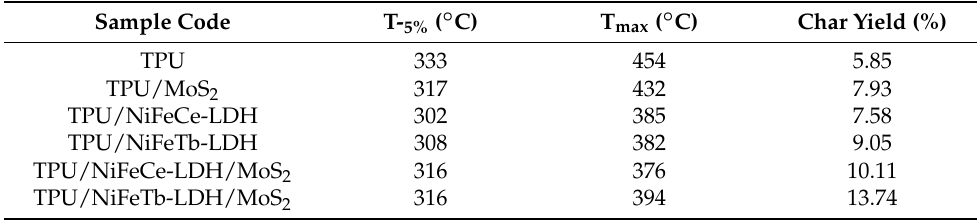
Table 2. Thermogravimetry data of TPU